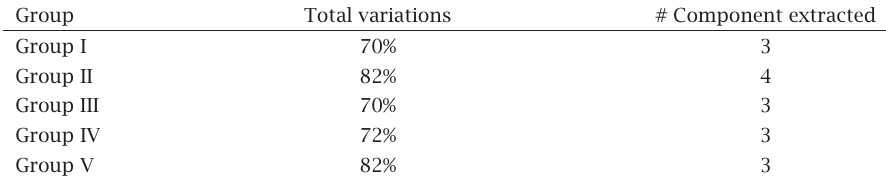
Table 5.2 . Total variations for each